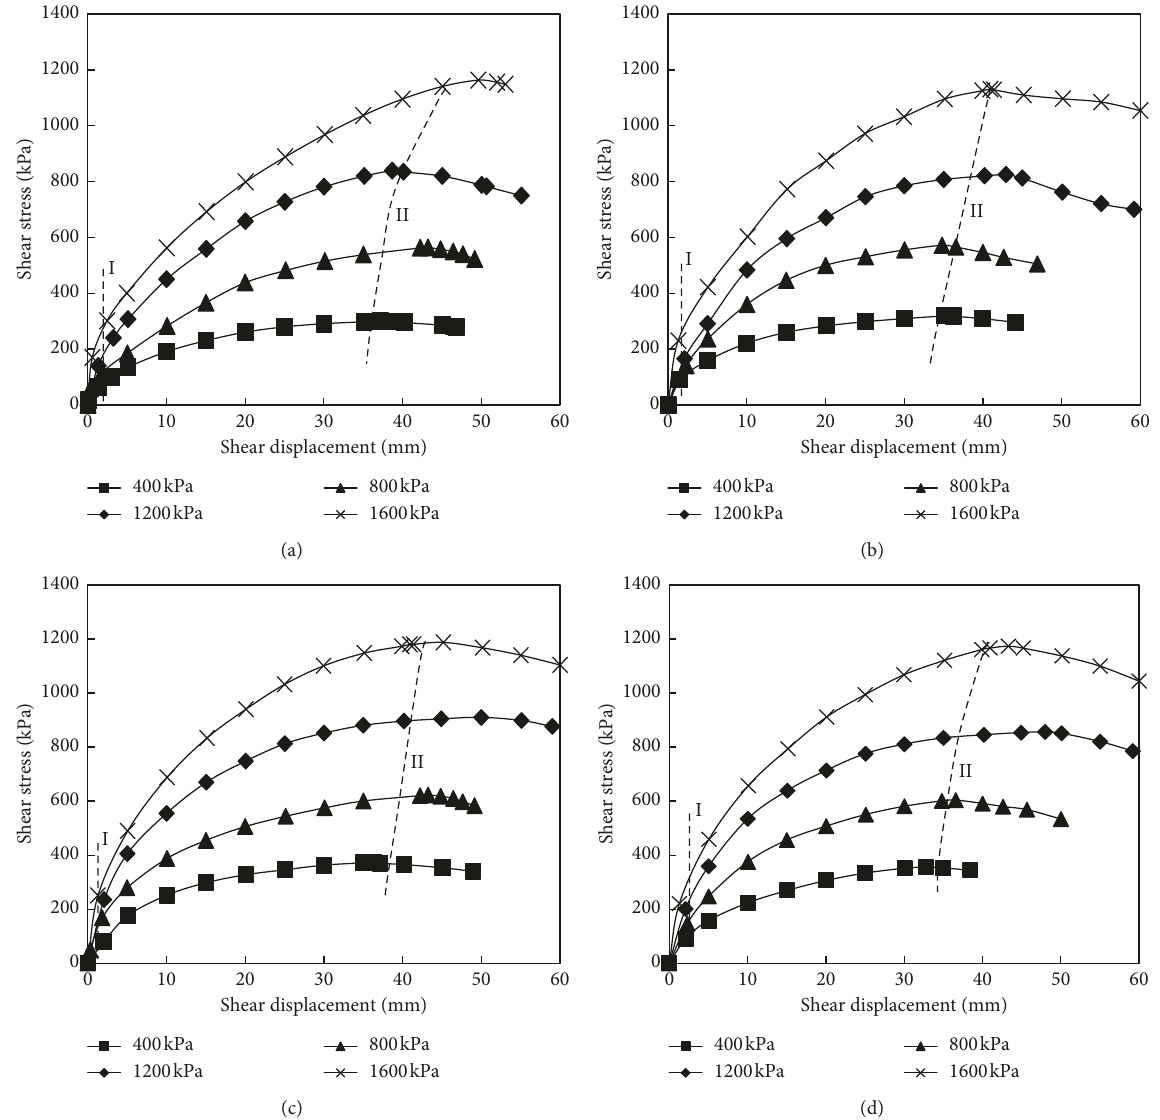
Figure 5: Shear stress-shear displacement curve of brick powder under high normal pressure. (a) 0% rate of reinforcement. (b) 2% rate of reinforcement. (c) 6% rate of reinforcement. (d) 10% rate of